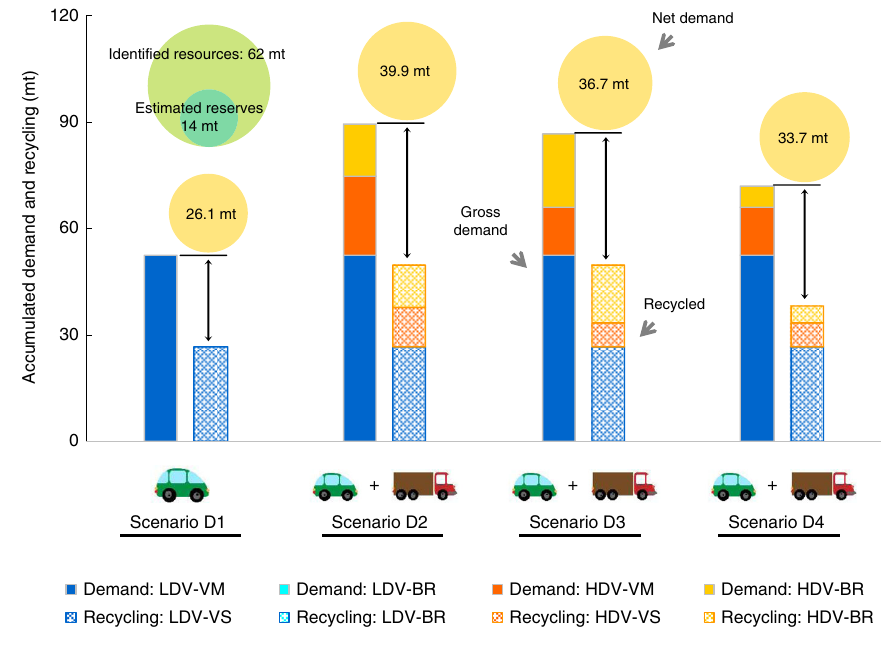
Fig. 2 Accumulated lithium demand and recycled lithium under different scenarios. The four groups of bars represent the results under scenarios D1, D2, D3, and D4, respectively. For each group of bars, the left bar indicates the accumulated gross demand; the right bar indicates the accumulated recycled lithium; the difference in the length of the two bars indicates the accumulated net demand, which is also indicated by the area of the circles above the bars and the numbers within the circles. The green circles represent the current estimates of global lithium reserves and the total identi fi ed lithium resources for comparison with the accumulated net demand. VM: Vehicle Manufacturing; VS: Vehicle Scrappage; BR: Battery Replacement. Source data are provided as a Source Data fi